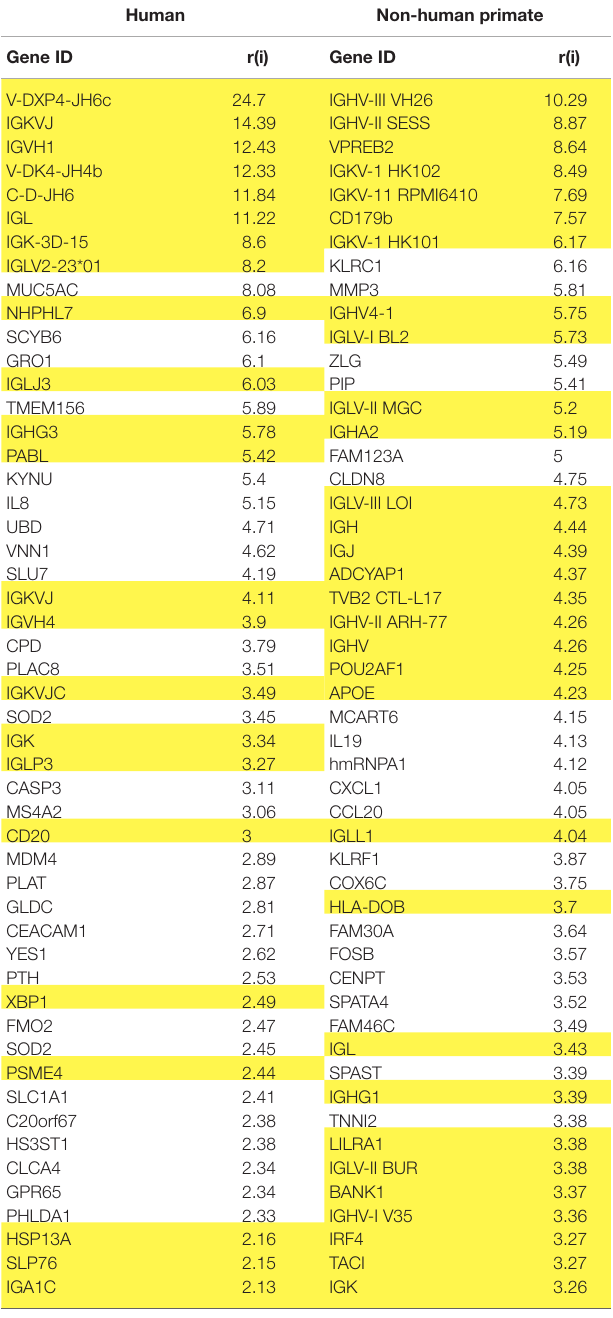
Genes highlighted in yellow associated with adaptive immune